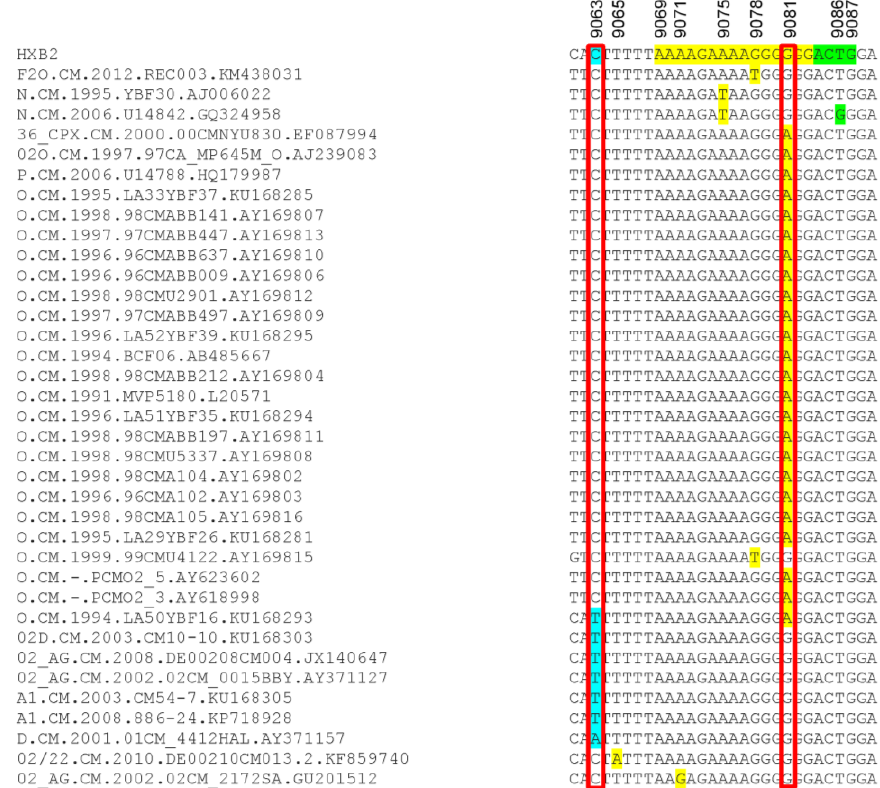
Figure 5. Mutations detected in the 3’-PPT and its flanking regions for database samples. The nucleotides alignment, using HXB2 as a reference sequence, are shown for the database samples in which mutations were detected. The 15 nucleotides of 3’-PPT sequences are shaded yellow. The 1 st four nucleotides of 3’LTR are shaded green. Region with mutation upstream of the 3-PPT (nucleotide position 9063) is shaded in sky blue. Nucleotide numbers correspond to the numbering of the HXB2 reference sequence.